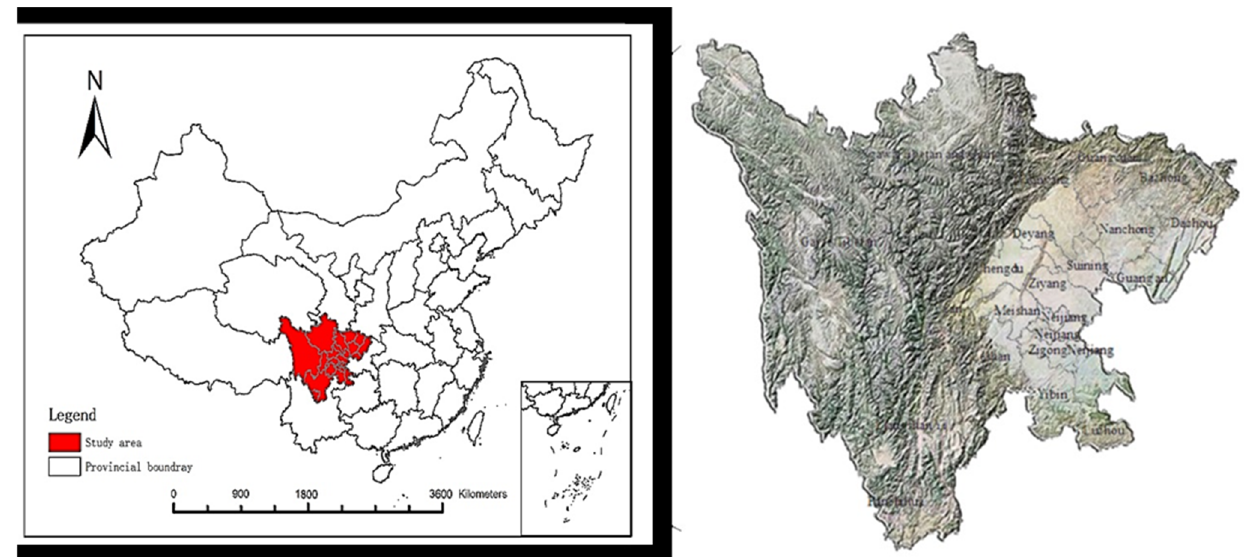
Figure 2. The location of Sichuan Province.